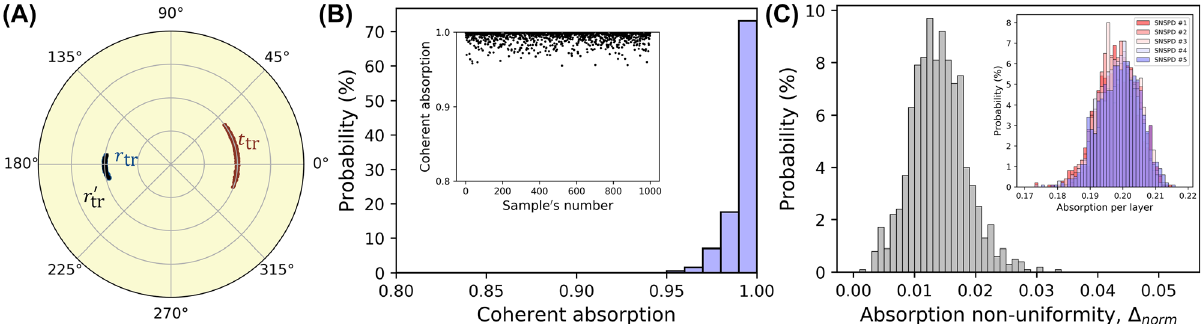
Figure 8: Statistical simulation of fabrication imperfection for the five-layer distributed detector. An ensemble of one thousand samples is generated where, for each sample, the thickness of nanowire sublayers and spacers is chosen randomly with fluctuation ± 5 % around the nominal values. (A) Optical response under traveling wave illumination within the ensemble. Due to the asymmetry of the structure, the reflection coefficient is slightly (blue dots), and right, r ′ (black dots), sides. (B) Fluctuation of coherent absorption in the ensemble. The inset different for illumination from the left, r tr tr shows the coherent absorption of each sample. (C) Fluctuation of the absorption non-uniformity in the ensemble. The inset shows the fluctuation of the absorption per each nanowire sublayer in the